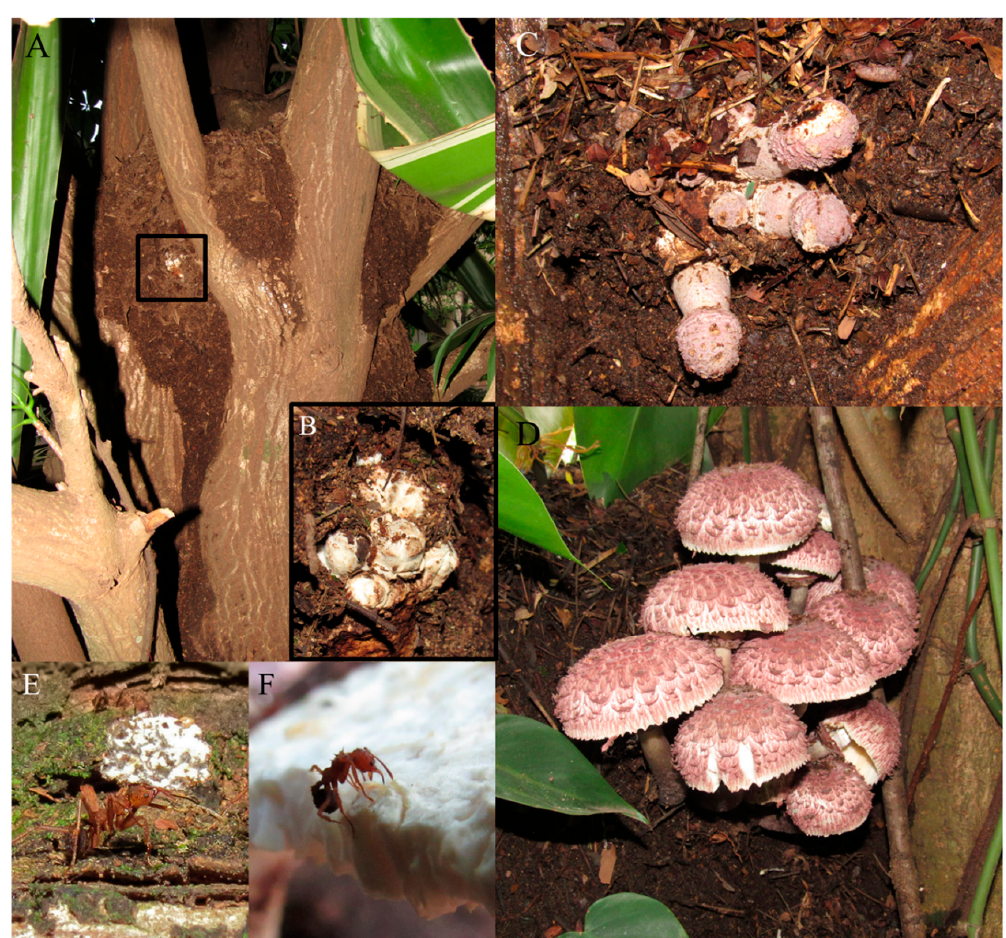
Figure 1. Basidiome occurrence in Acromyrmex coronatus nest in Rio Claro, State of São Paulo, Brazil. ( A , B ) Basidiome primordia in a nest located in a tree fork. ( C , D ) Emerged basidiomes. ( E ) Garden transfer by an A. coronatus worker (see also Supplementary Material 2 for video). ( F ) A. coronatus worker attempting to cut parts of the basidiome.